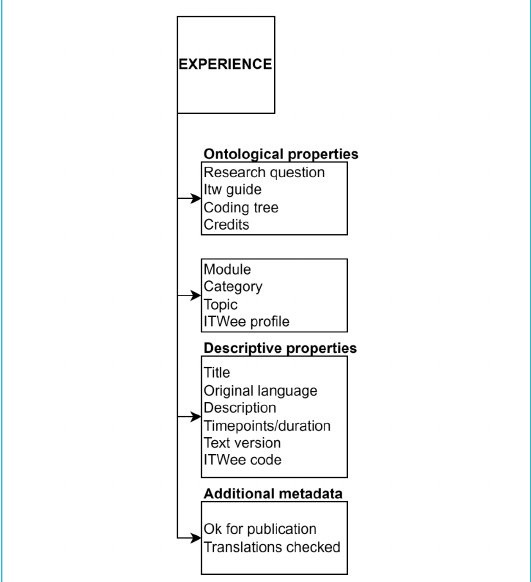
Figure 3: Properties of experiences in the DIPEx